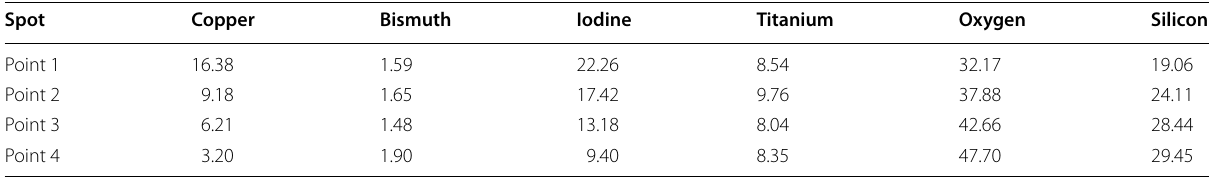
Table 12 Elemental distribution (atomic %) of the individual elements observed on Cu in Fig. 8e